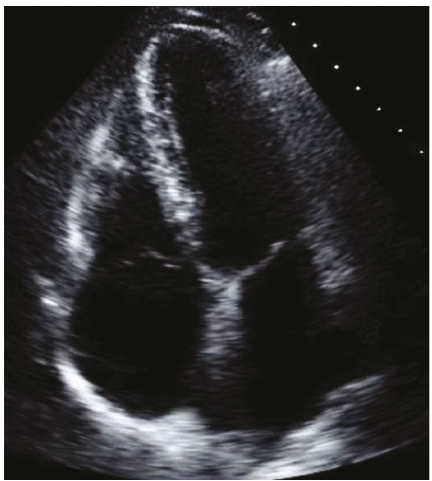
Figure 2: Apical four-chamber view of the heart with no evidence of a source of